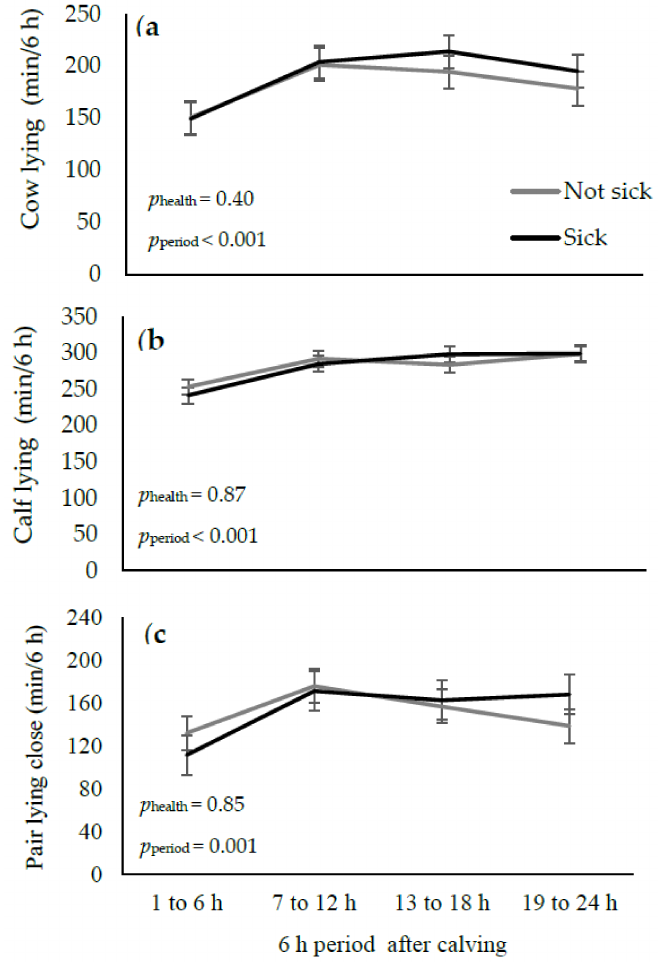
Figure 2. LS means and SE for lying behaviour of ‘sick’ (black lines; clinical sign of illness and rectal temperature ≥ 39.1 ◦ C 9 within 24 h after calving) and ‘not sick’ (no clinical sign of illness and rectal temperature ≥ 39.1 ◦ C within 3 d after calving) cows and their calves in the 24 h after calving across 6 h periods: ( a ) Lying time of the cow; ( b ) Lying time of the calf; ( c ) Time that the cow-calf pair spent lying close together (within 1 calf 2